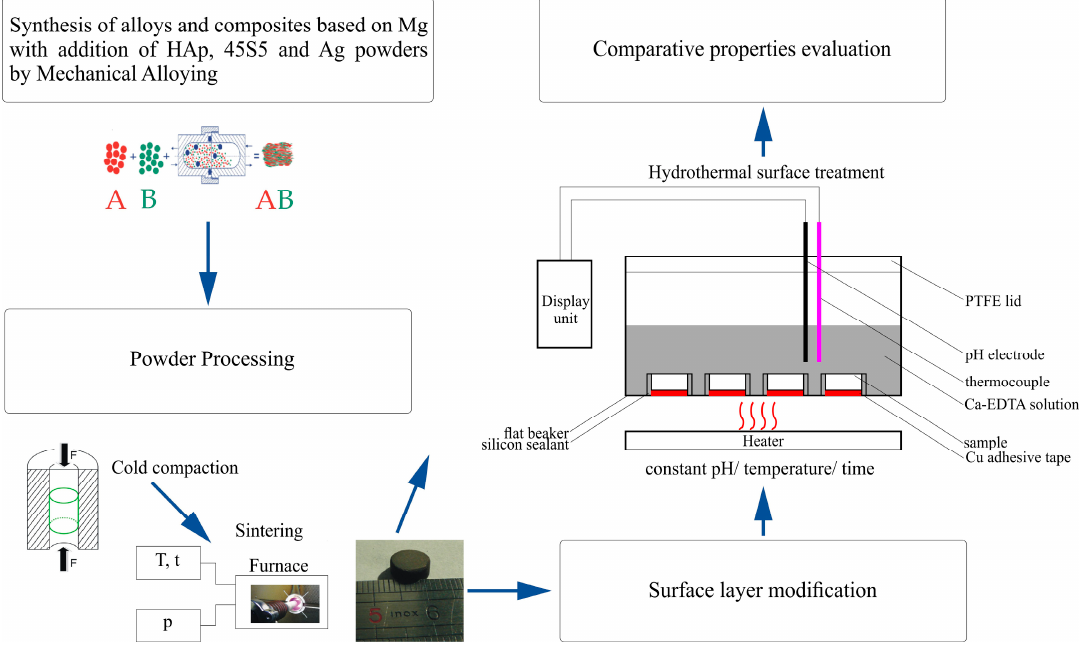
Figure 1. Schematic illustration of the experiment arrangement.